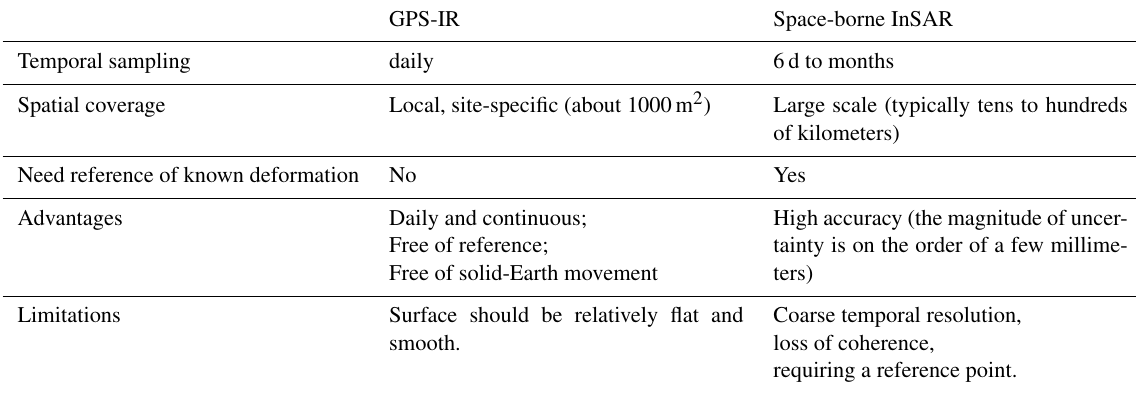
Table 4. Comparing GPS-IR and space-borne InSAR for measuring surface elevation changes in permafrost areas GPS-IR Space-borne InSAR Temporal sampling